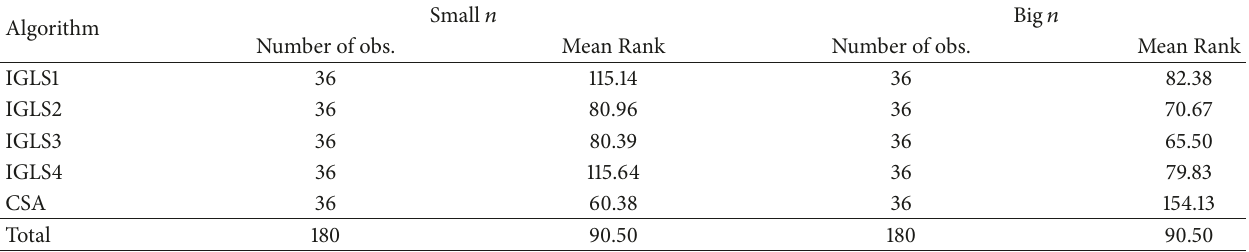
∗ Note that average scores were used for